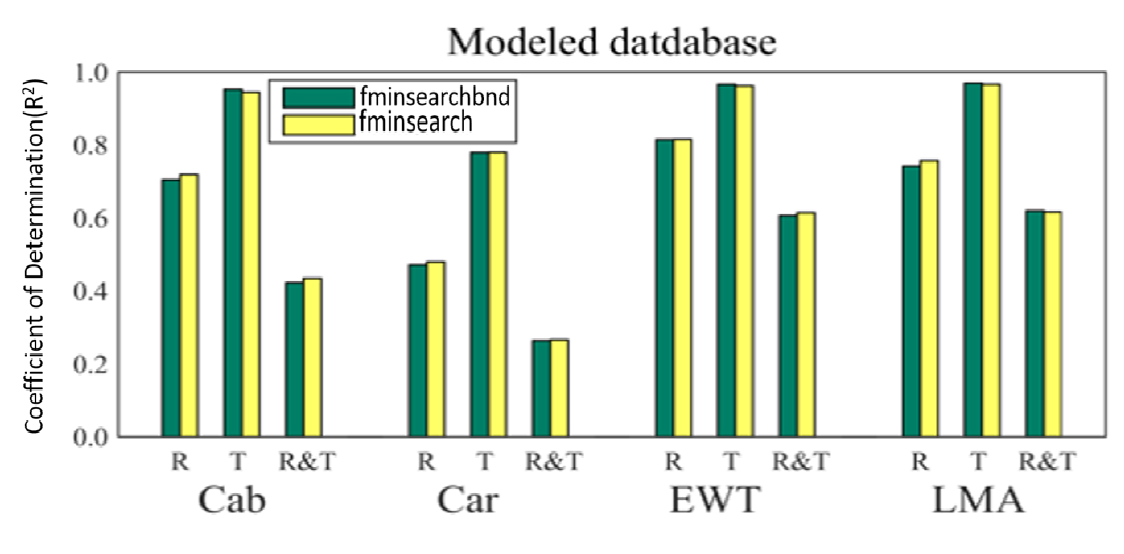
Figure 2 . Values of coefficient of determination (R 2 ) using the N-M method to invert biochemical parameters based on the spectra of reflectance (R), transmittance (T) and both (R&T). The data are from modelled